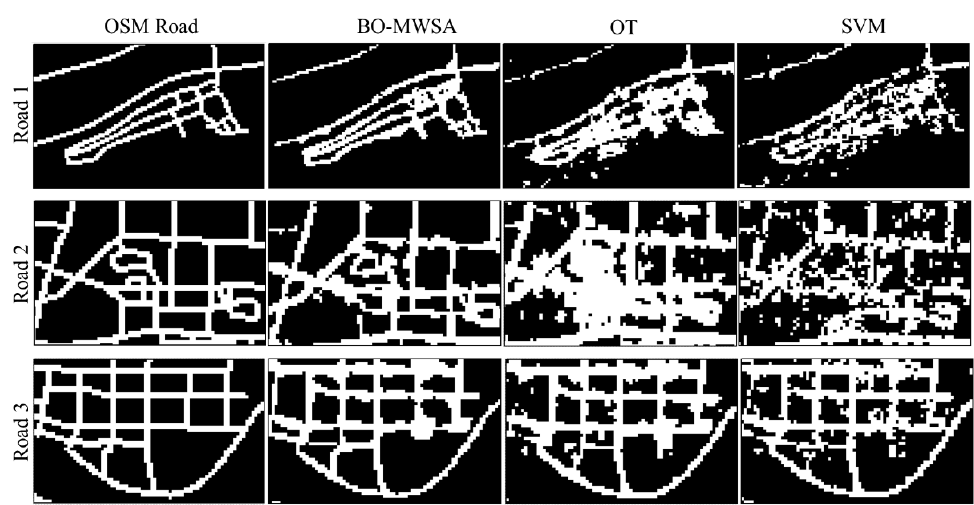
Figure 6. Comparison of road extraction results. Road 1 is located in Lhasa Railway Station with large traffic flow in the city; Road 2 is located in the Potala Palace; and Road 3 is Jiangsu Avenue, representing a residential area. Table 1. F1 scores of BO-MWSA, SVM, and